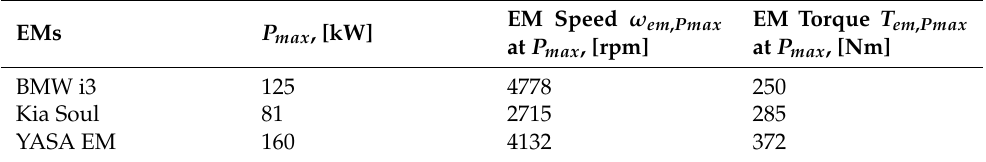
Table 2. Main parameters of EMs used in different commercial BEVs.